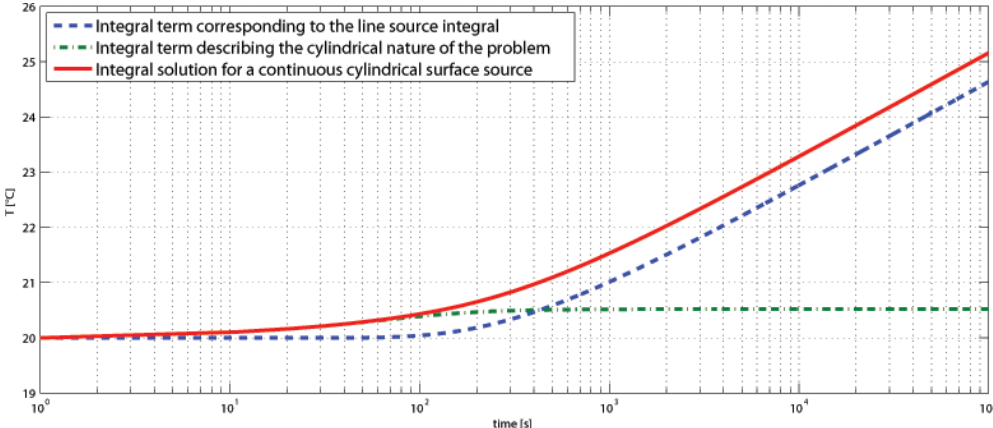
Fig. 1. Integral solutions for a continuous cylindrical surface source. The used parameters match those of a measurement with LNP01 performed in Agar. ( r 1 = 0 . 0075mm; Q cyl = 6 . 15Wm − 1 ; k = 0 . 6Wm − 1 K − 1 ; µ = 11 × 10 − 8 m 2 s − 1 ).